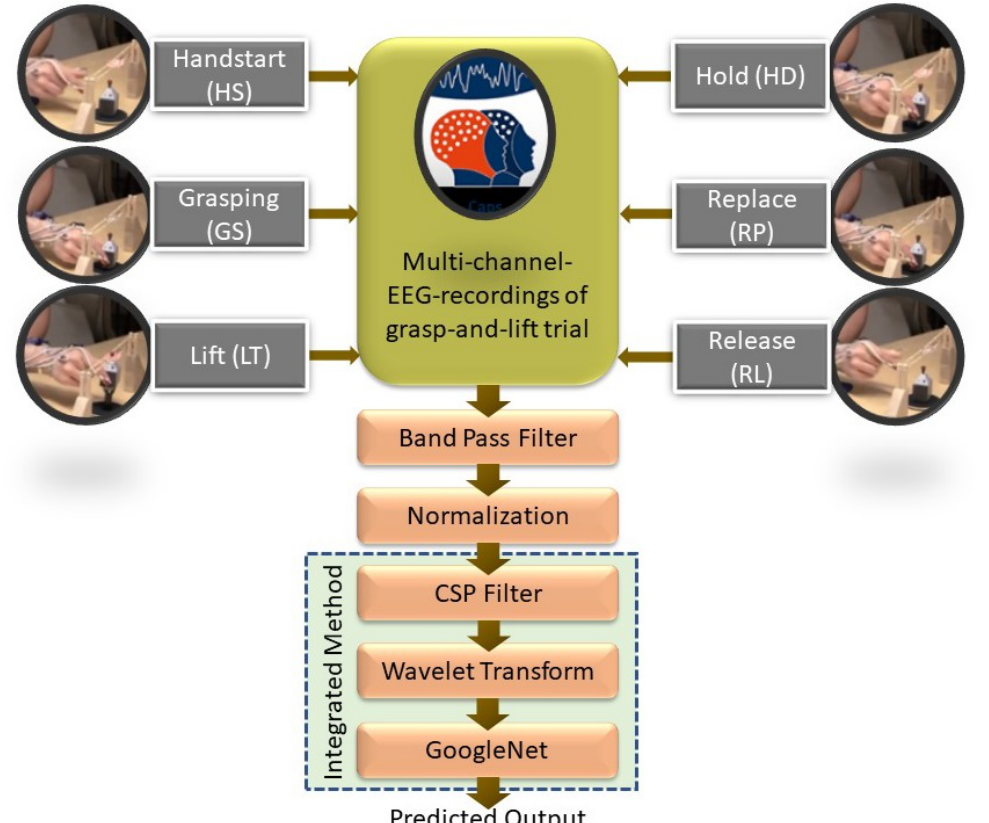
Figure 1. General framework for classification of motor electroencephalogram (EEG) events using a common spatial pattern (CSP) filter and a continuous wavelet transform (CWT).